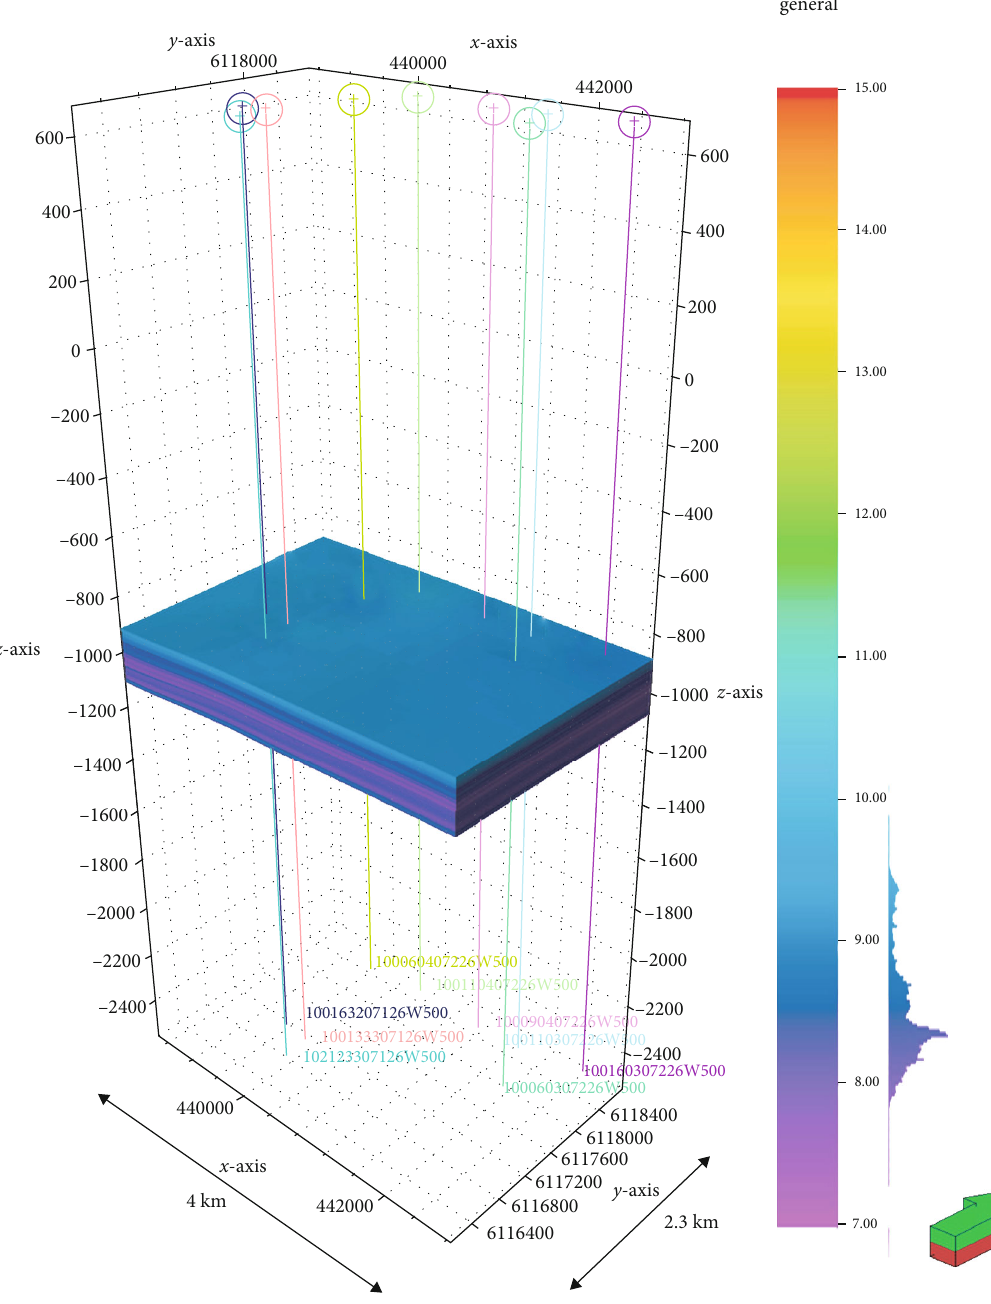
Figure 9: The three-dimensional model result of eastern area. It represents the division of upper and lower member of Montney Formation. The upper member has relatively higher value of desorbed gas volume than the lower member. Around the UWI 100110407226W500 have the highest and lowest in eastern area (nearby UWI 100163207126W500) of desorbed gas volume (the legend scale of Figures 9 – 11 set to be the